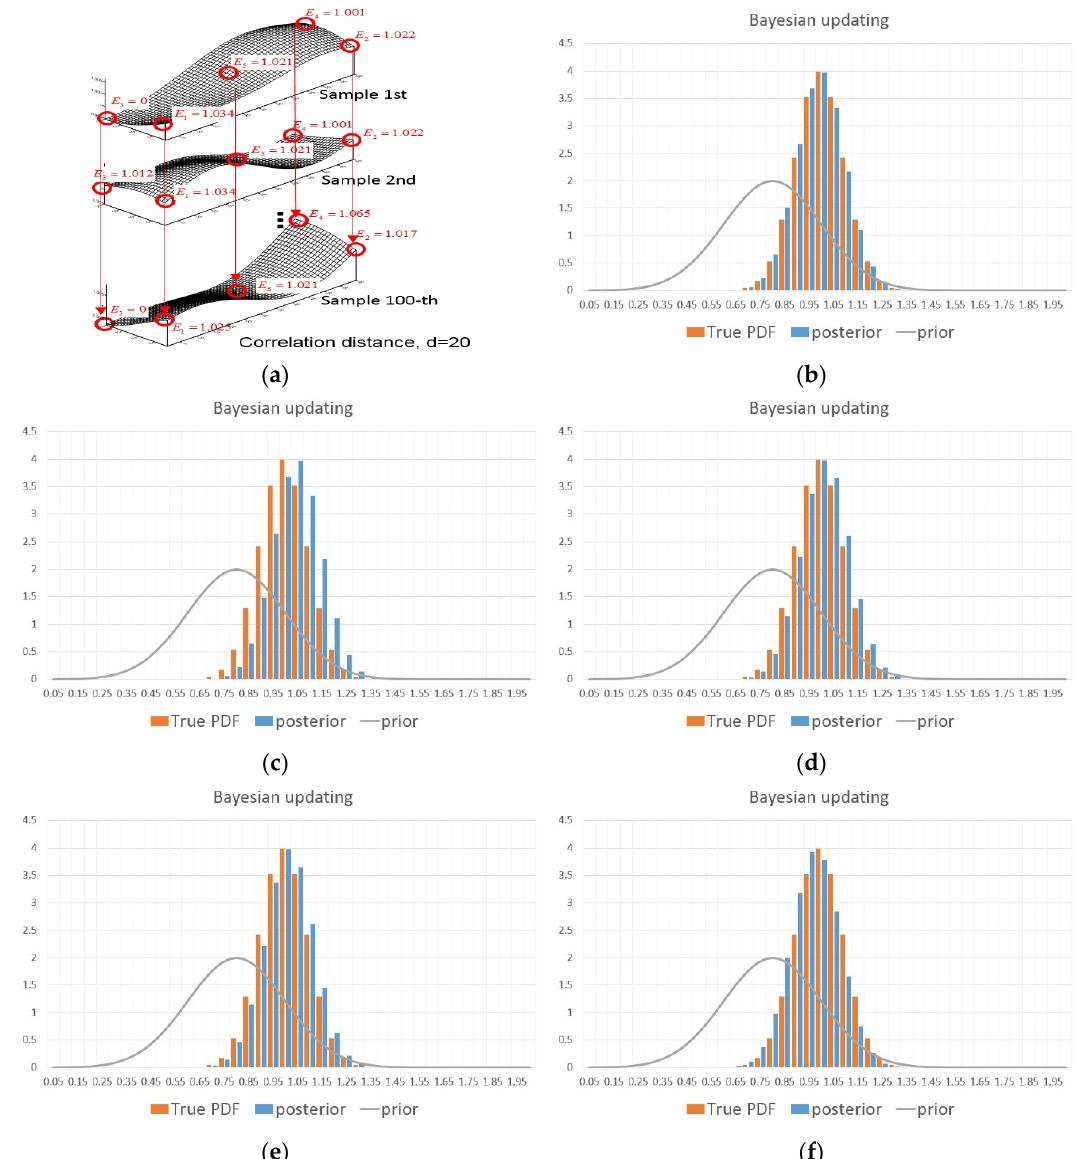
Figure 10. Bayesian updating at the stochastic field of the correlation distance d = 10.0: ( a ) How to perform Bayesian updating; ( b ) Observation point 1; ( c ) Observation point 2; ( d ) Observation point 3; ( e ) Observation point 4; ( f ) Observation point 5.